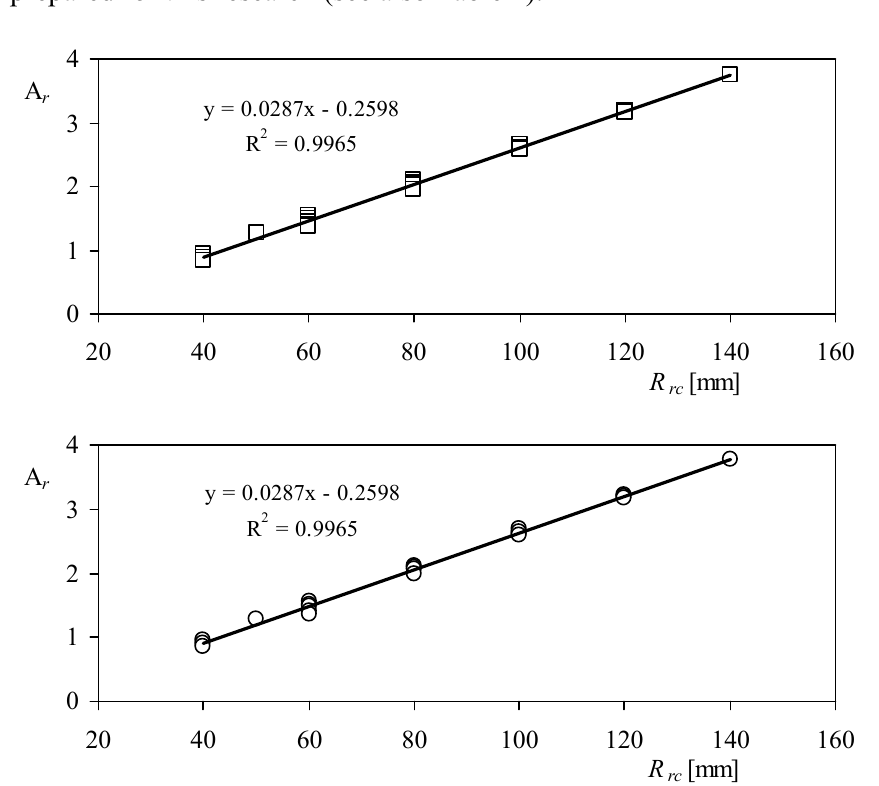
Figure 8. Calibration coefficients, A for the Cl-100075 ( top ) and the Ory-107 ( bottom ) anemometers tested each one with all the rotors prepared for this research (see also Table 1).